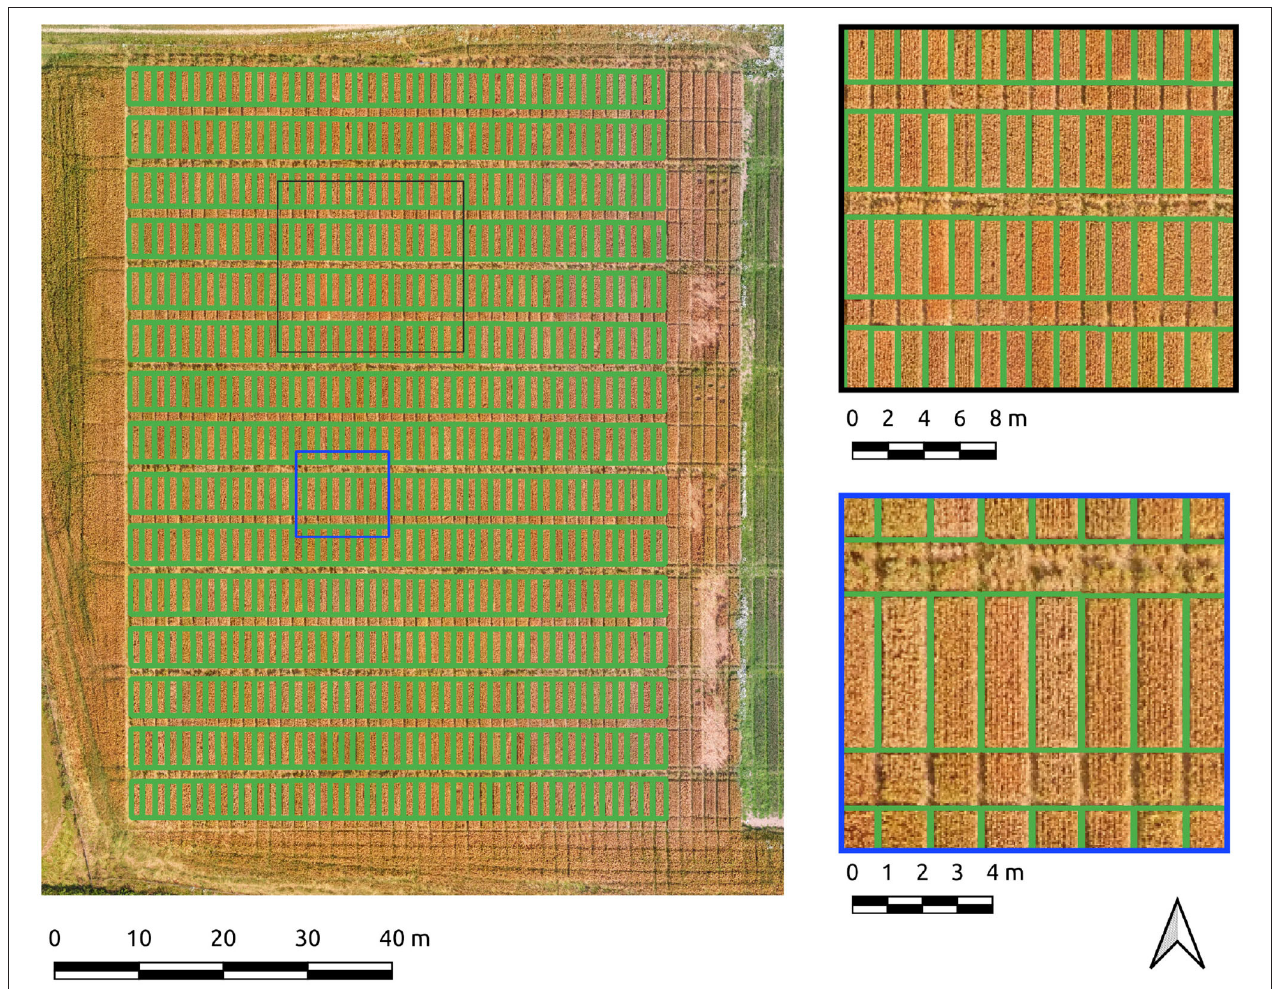
FIGURE 5 | Segmentation results on the Cae Tatws site dataset use PC edge detection.